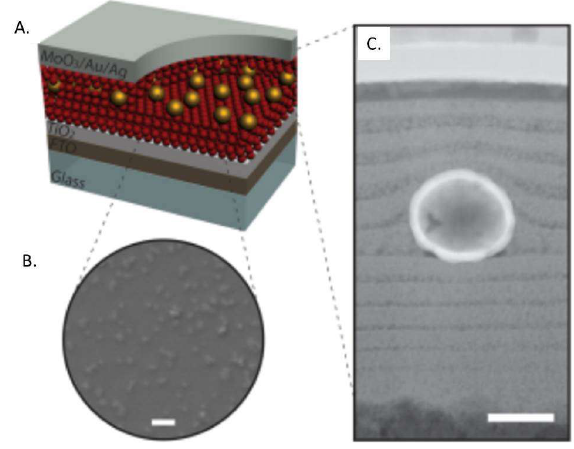
Fig. 8. Plasmonic–excitonic solar cell device design. (A) Schematic of the PbS CQD DH device with embedded nanoshells. (B) Top view scanning electron microscope image showing representative den- sity of nanoshells after CQD deposition. Scale bar, 1 µm. (c)